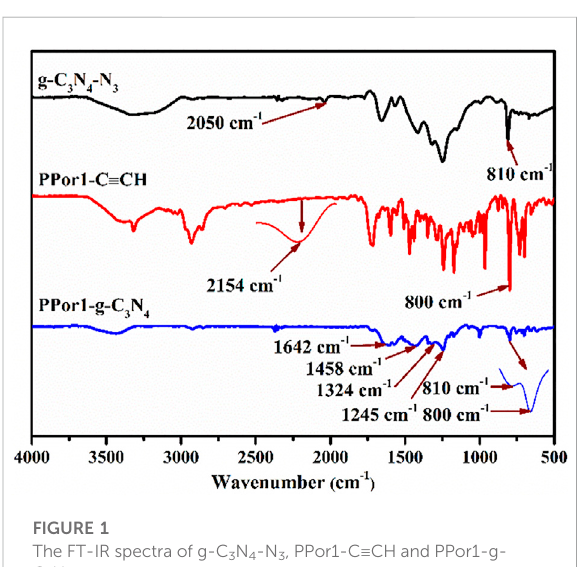
FIGURE 2 XRD patterns of g-C 3 N 4 -N 3 , PPor1-C ≡ CH and PPor1-g- C 3 N 4